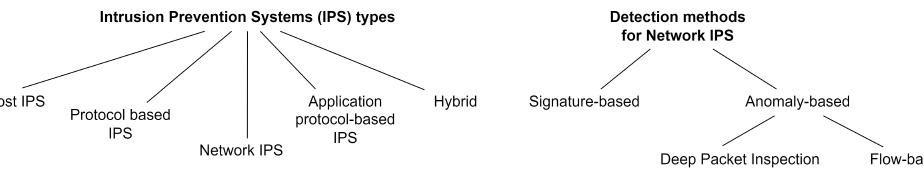
Figure 2. Network Intrusion Prevention Systems types and detection